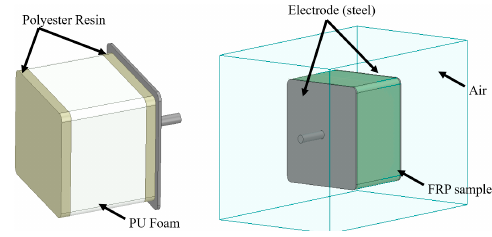
Figure 5. The experimental setup. Table 1. Material-based parameters.